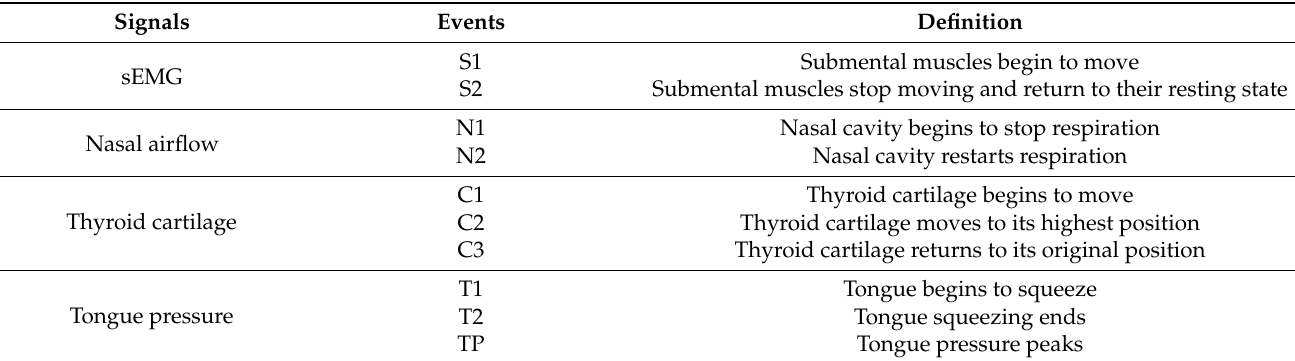
Figure 5. Integrated signal waveforms. Table 1. Events on the signal